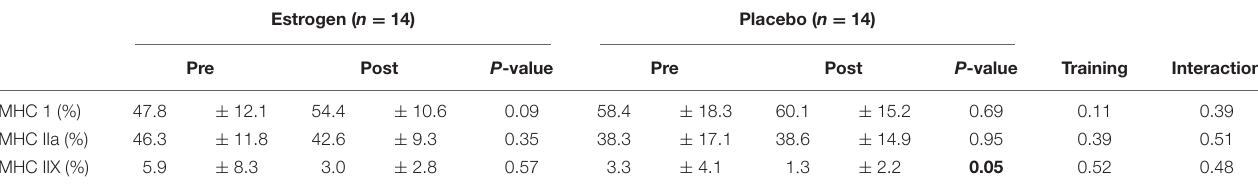
TABLE 2 | Myosin heavy chain distribution.